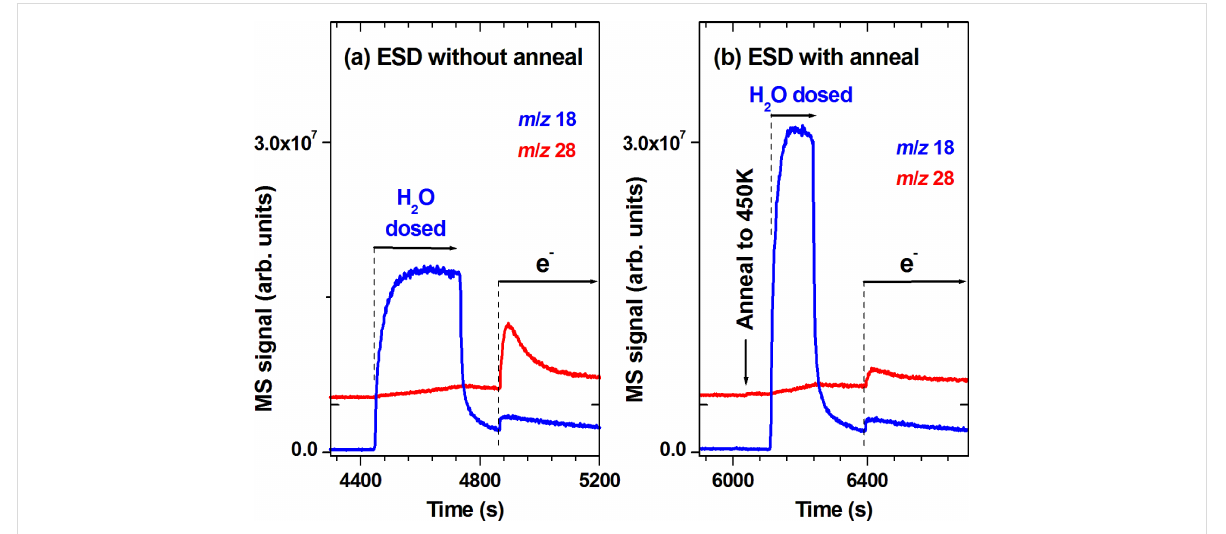
Figure 6: MS signals recorded during leaking of H 2 O (H 2 O) and electron exposure at E 0 = 31 eV (e − ) of a 30 layer film of MeCpPtMe 3 deposited and held at 105 K. Prior to the processes steps shown here, the film was degraded by electron exposure at the same energy until ESD of CH 4 had decayed. The amount of H 2 O vapour was the same as used for depositing the MeCpPtMe 3 film. This procedure was performed (a) without and (b) with an annealing step to 450 K applied prior to leaking of H 2 O. The m / z ratios 18 and 28 are shown to visualize leaking of H 2 O and formation of CO. The dashed line marks the start of the irradiation period with (a) I p = 10 µA/cm 2 and (b) I p = 12 µA/cm 2